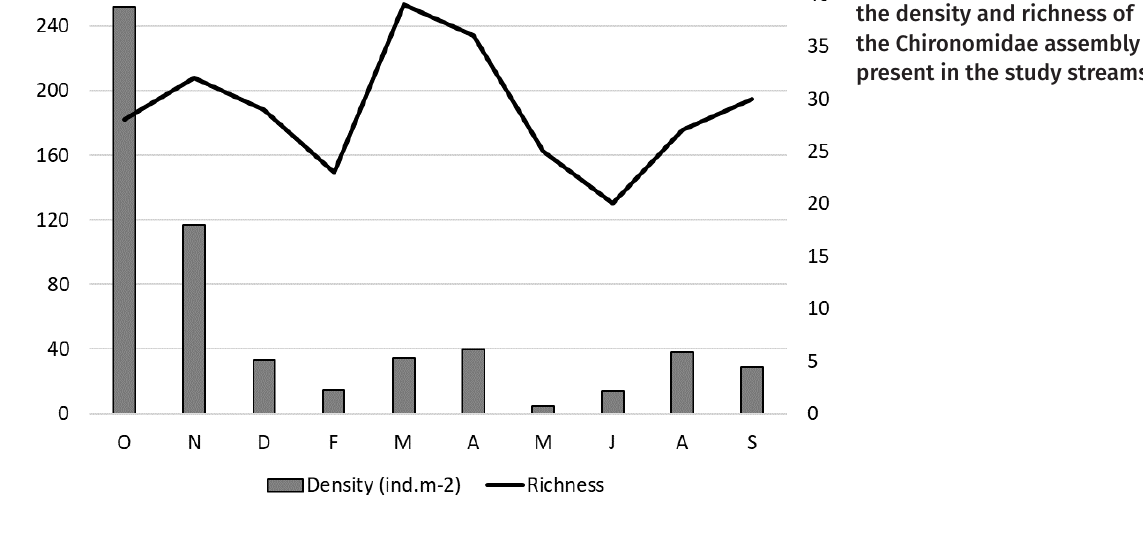
Figure 2. Monthly variation of the density and richness of the Chironomidae assembly present in the study